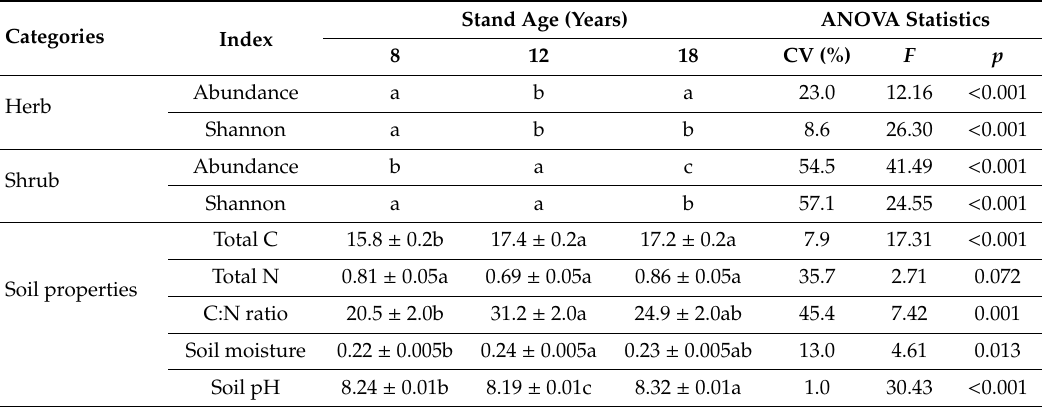
Figure 1. The di ff erences (mean ± 1SE) in ( A ) abundance (% cover), and ( B ) Shannon diversity index of the herb and shrub layers among three stand ages. Table 1. One-way analysis of variance (ANOVA). The estimated plot level mean values of the abundance and Shannon’s diversity index for the herb and shrub vegetation categories, the total soil carbon soil pH for three stand ages of a poplar plantation. Separation of means was determined by a Tukey test where applicable. Di ff erent letters indicate that means were significantly di ff erent at p < 0.05. The degrees of freedom were 2 for the nominator and 42 for the denominator for all